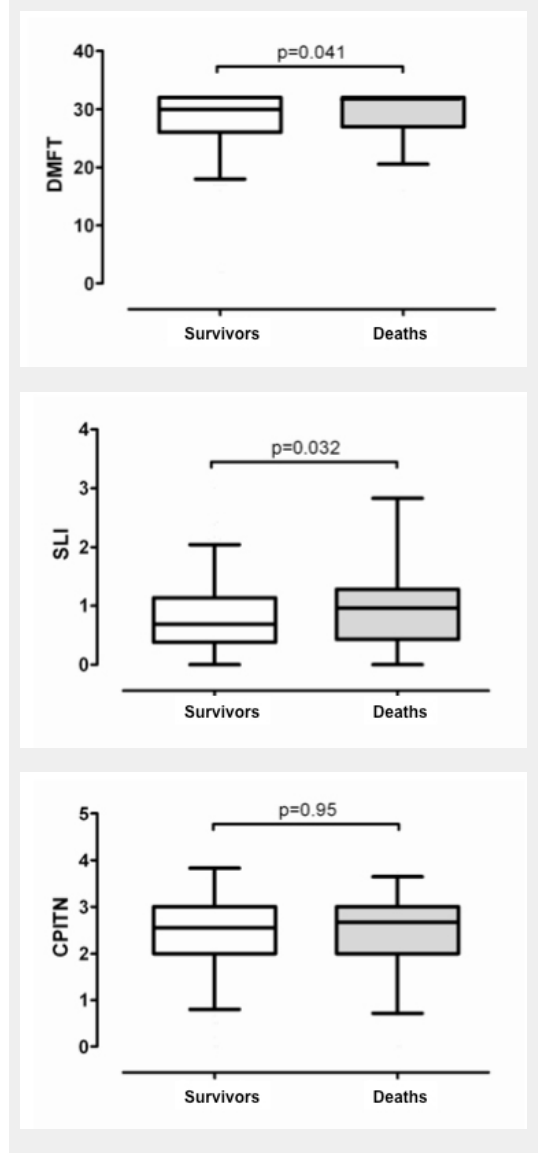
DMFT (fig. 1A), SLI (fig. 1B), and CPITN (fig. 1C) indices in patients who died (n = 107) compared to survivors (n = 304). Box bottom marks the 25th percentile, the line within marks the median, and the box top marks the 75th percentile; the bottom and top of the vertical lines mark the 5th and 95th percentiles